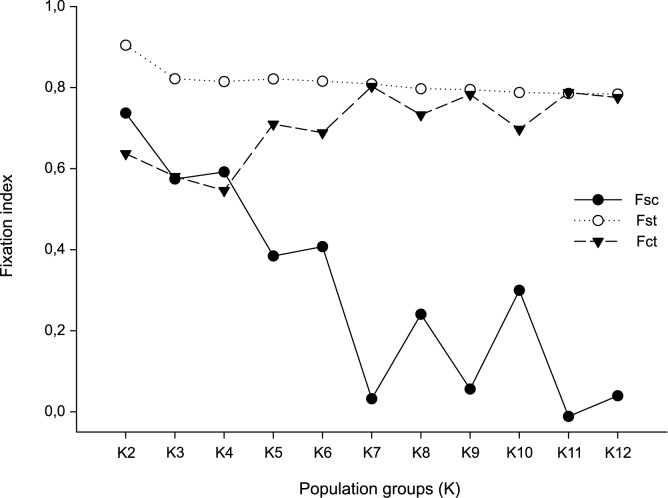
Spatial analysis of molecular variance (SAMOVA) of the 13 populations of Acromyrmex striatus.The fixation indexes were calculated independently for each group K. The most significant value of the fixation index FCT for a given K reports the best grouping of populations of A. striatus.